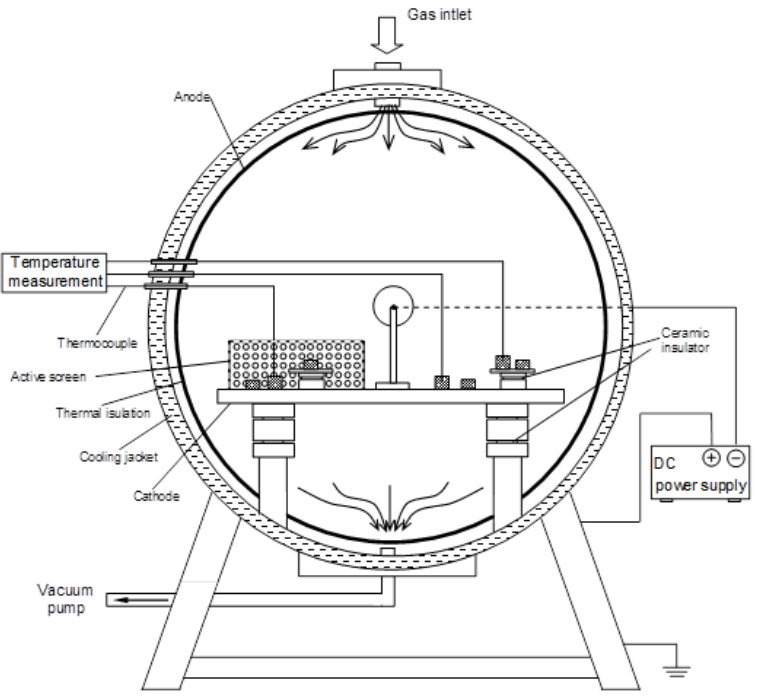
Figure 1. Cross-section of the glow-discharge